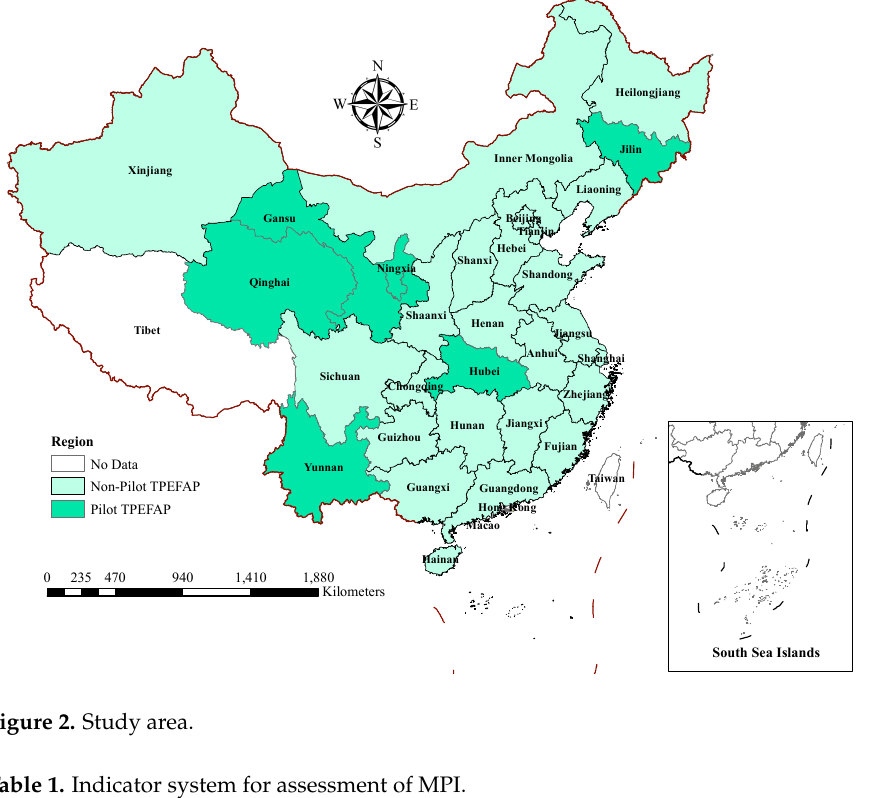
Figure 2. Study area. 176